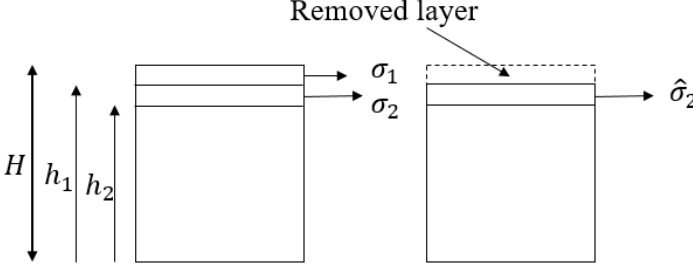
Figure 3. Stress correction factor due to redistribution of residual stress after layer removal and the parameters defined in Equation (7).